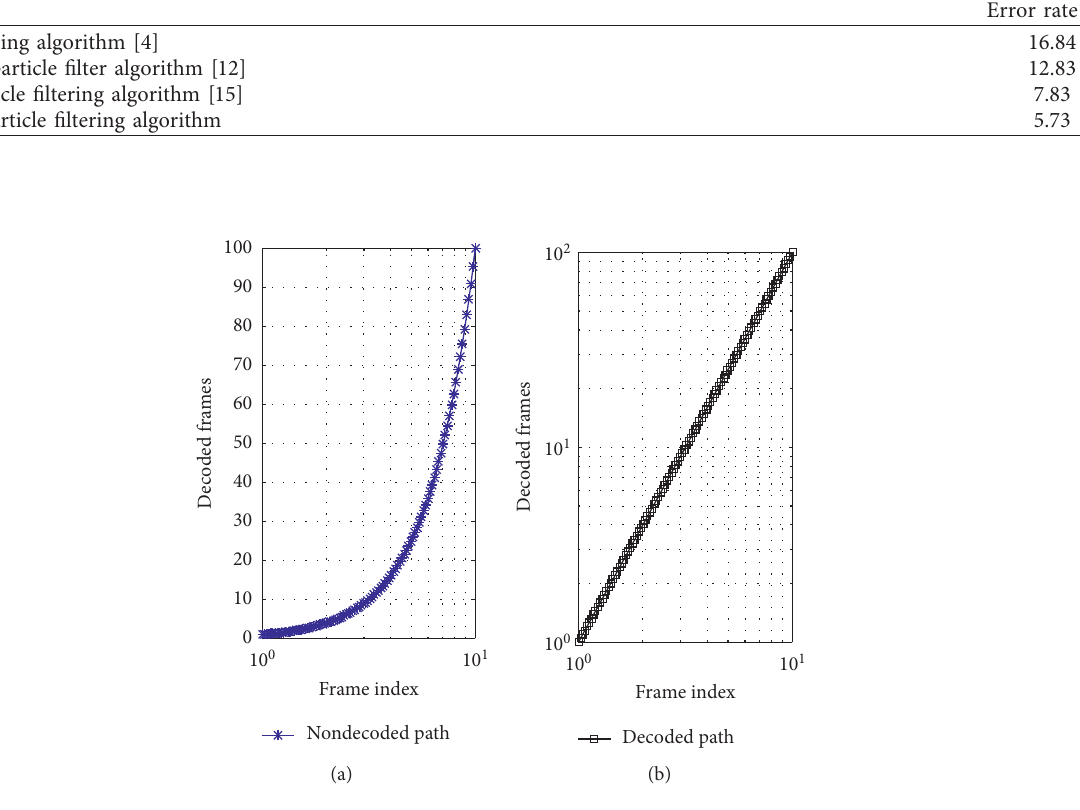
Figure 7: Stability data when the voice to be recognized is a keyword.